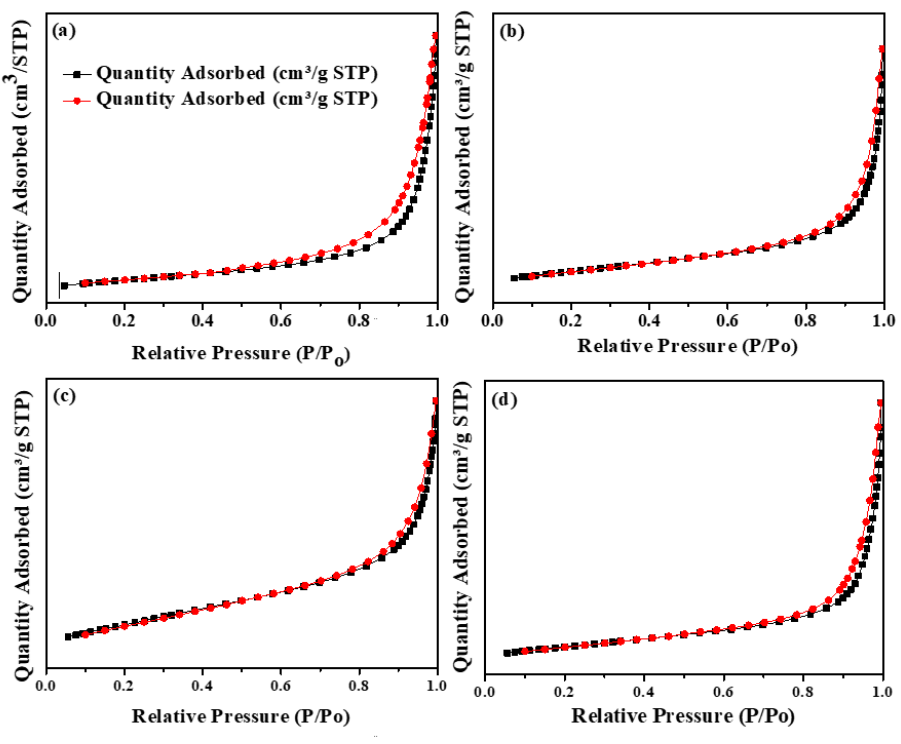
Figure 4. The N 2 adsorption-desorption isotherms of ( a ) pure g-C 3 N 4 , ( b ) 0.5CDs/g-C 3 N 4 , ( c ) 1.0CDs/g-C 3 N 4 , and ( d ) 1.5CDs/g-C 3 N 4 . Table 2. Textural properties of the synthesized pure g-C 3 N 4 and CDs/g-C 3 N 4 photocatalysts obtained from the N 2 adsorption-desorption